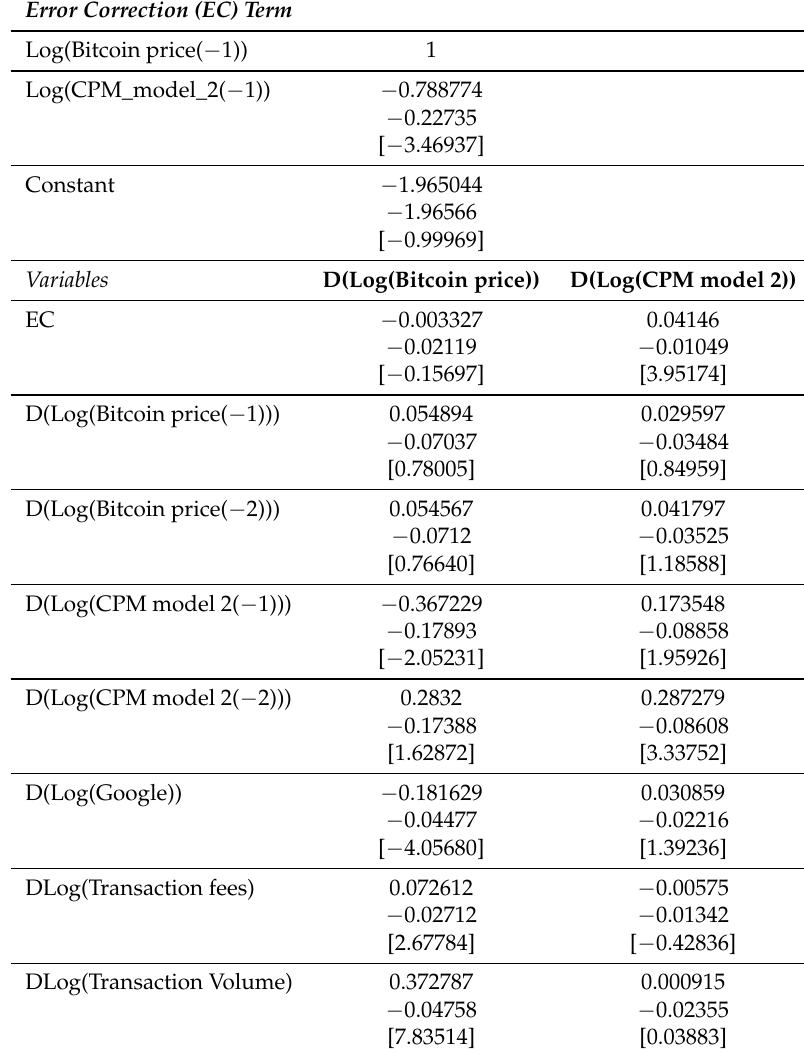
VECMX(2) for Log(Bitcoin price) and Log(CPM model 2), with Log(transaction fees), Log(Google), and Log(Transaction volume) as exogenous variables.